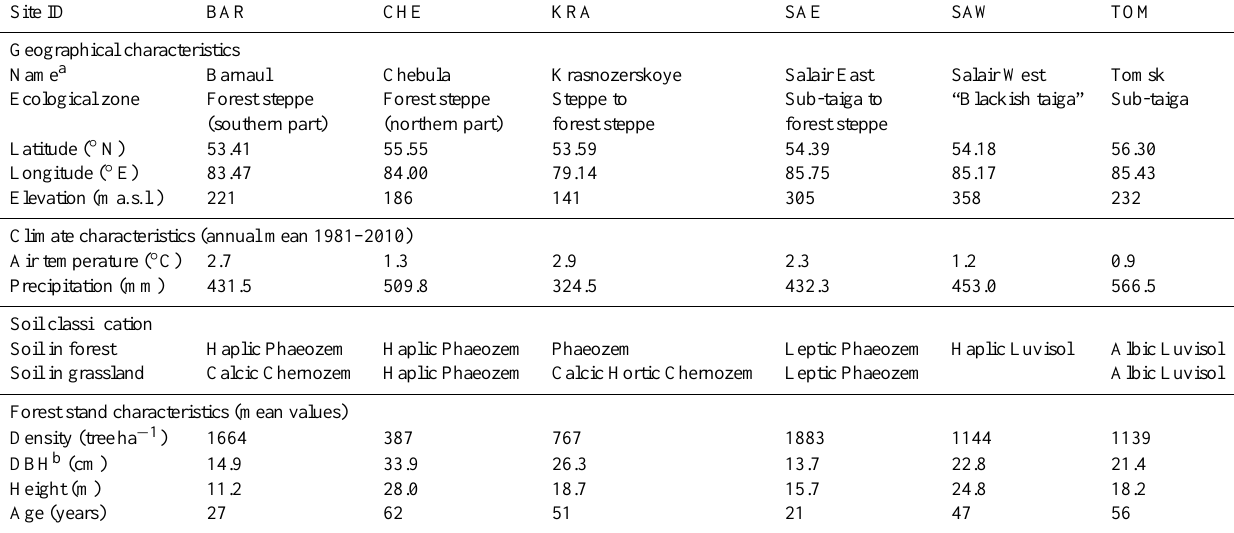
Table 1. Main characteristics of the study sites. Additional information is provided in Tables S1–S3. Site ID BAR CHE